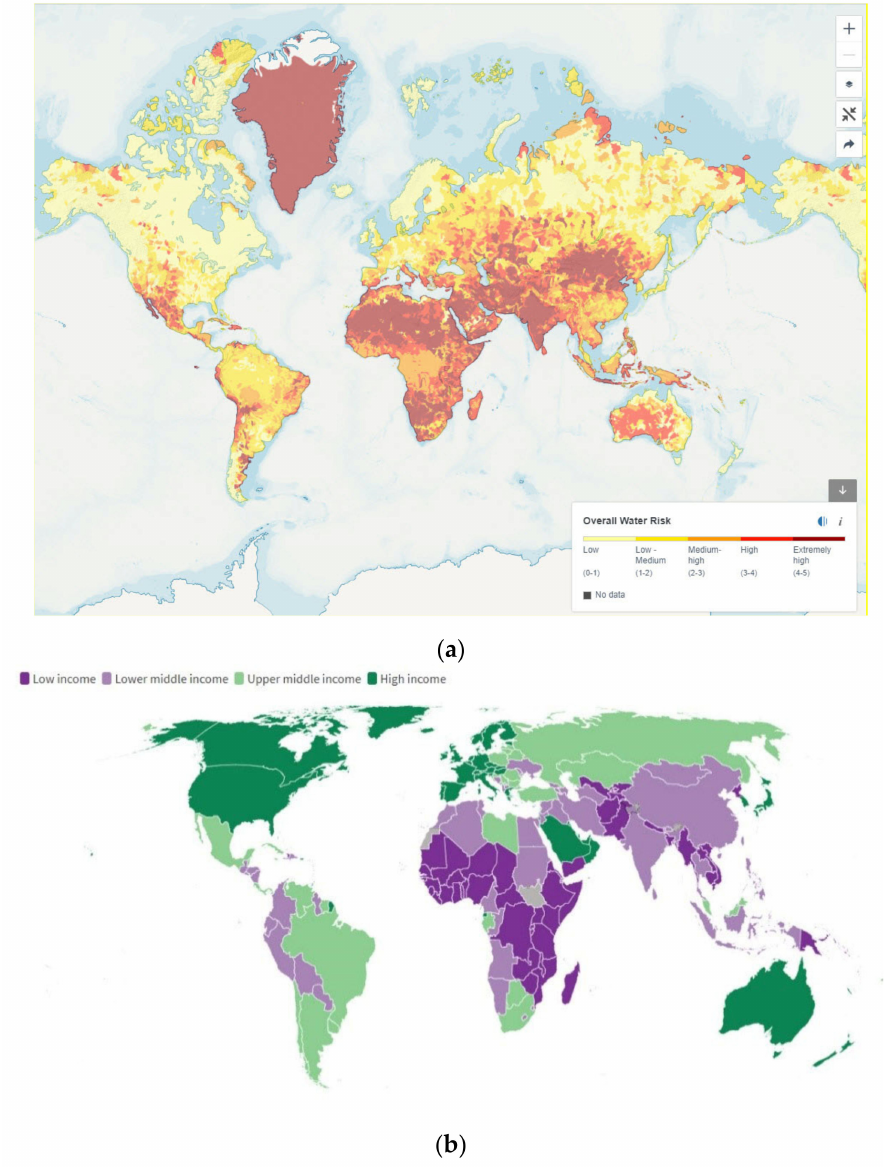
Figure 5. ( a ) Water Risk Atlas [174]; ( b ) income distribution, 2007